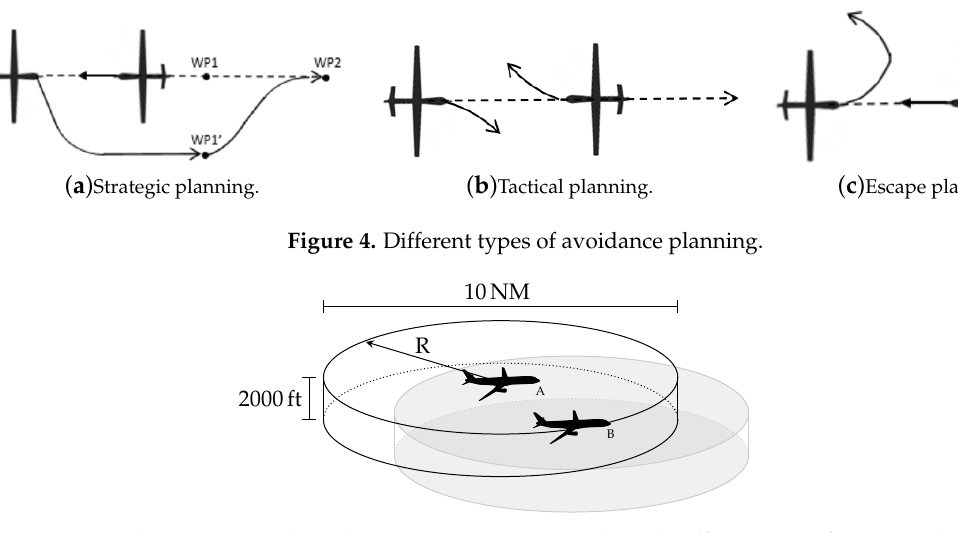
Figure 5. The International Civil Aviation Organization’s (ICAO) self separation for manned aviation: 5NM horizontal separation and 1000ft vertical